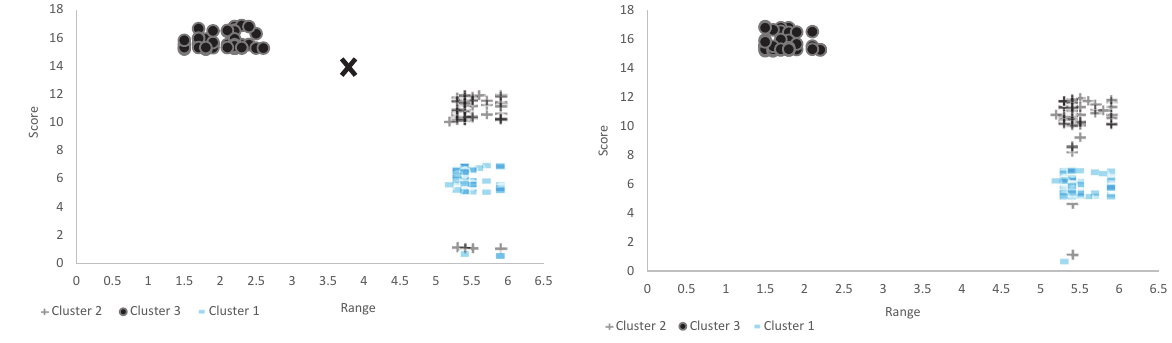
Fig. 2. Using K-medoids for clustering where cluster centers are chosen among real parts